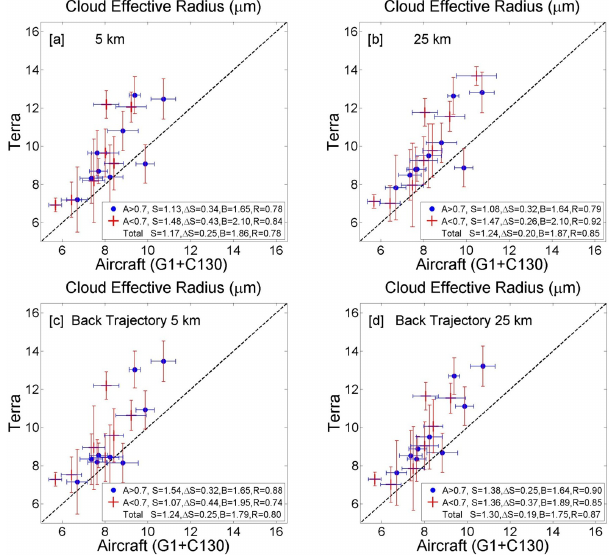
Fig. 5. Comparison of cloud effective radius retrieved from Terra- MODIS with combined in-situ measurements from both G-1 and C- 130: top two plots for un-projected positions at 5 and 25km domain averages; bottom two plots for projected positions. The vertical er- ror bars indicate the MODIS error product, whereas the horizontal error bars denote the standard deviation of aircraft measurements. The capital letters A , S , 1S , B and R represent adiabaticity, slope, standard deviation of the slope, bias and correlation coefficient, re- spectively (used in the other figures in this paper). The dashed lines represent 1:1